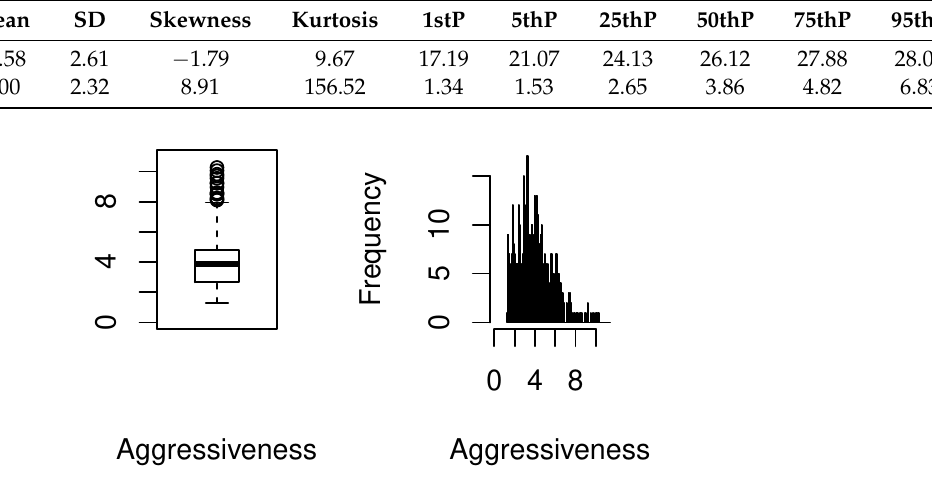
Figure 1. Boxplot and histogram of provider billing aggressiveness for Procedure